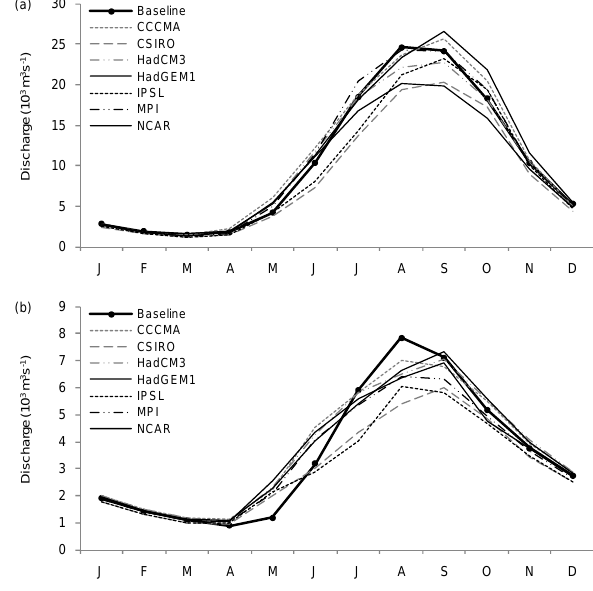
Fig. 5. 2 ◦ C climate change signal across seven GCMs: (a) mean monthly discharge of the Mekong at Pakse (Mekong 2), (b) mean monthly discharge of the Lancang sub-basin at